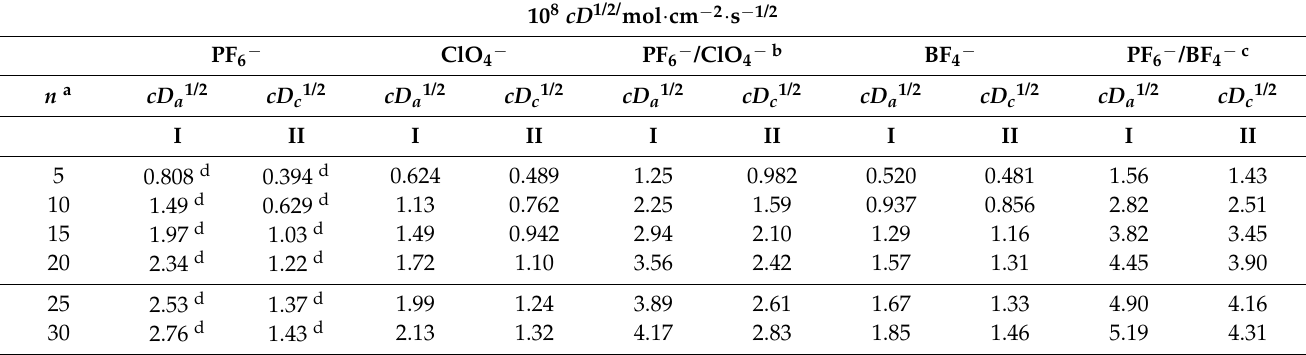
Table 4. Kinetic data for poly [Ni(salcn(Me))] in various electrolyte solutions (10 − 1 mol · dm − 3 ) in CH 2 Cl 2 .